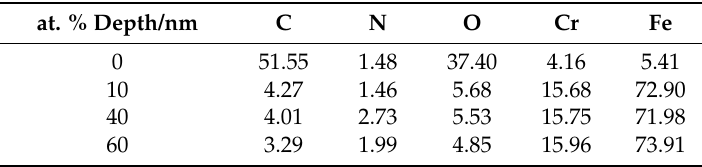
Table 1. Atomic concentrations of S0 at different depths.